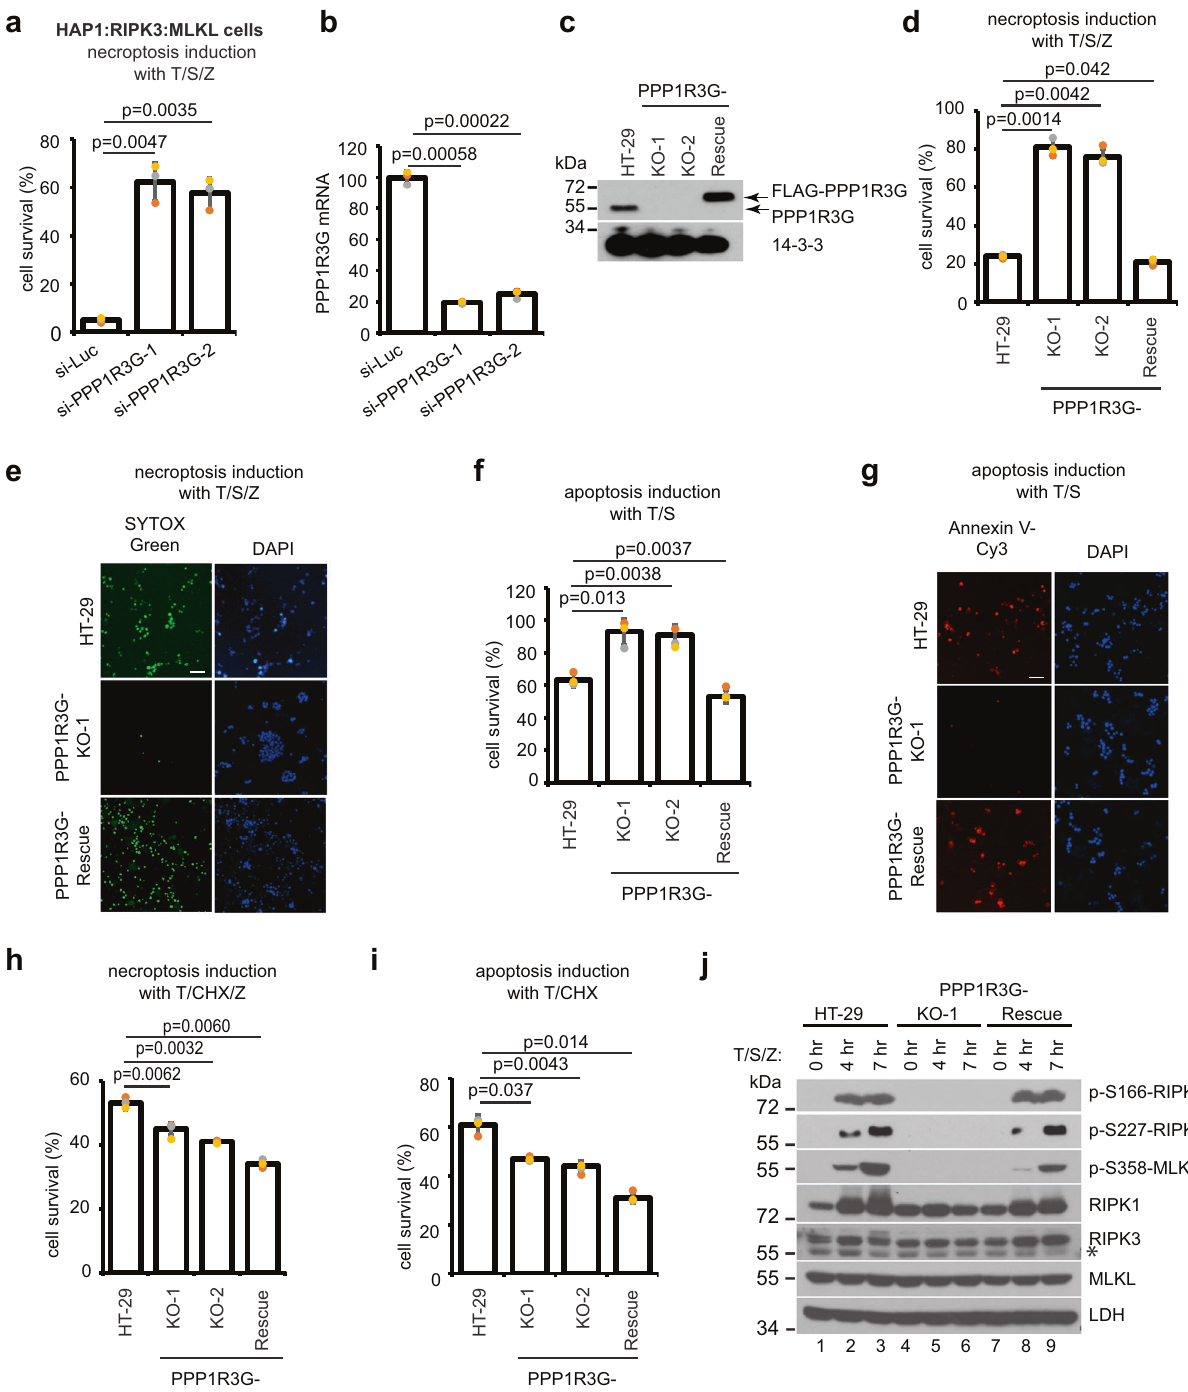
validate the hits, we performed a secondary screen using small addition, knockout of PPP1R3G also blocked T/S-induced interfering RNAs (siRNAs) targeting the top hits in HAP1:- apoptosis, assayed by CellTiter-Glo and Annexin V staining RIPK3:MLKL cells. Among many positive hits, silencing (Fig. 2f, g). However, when a protein synthesis inhibitor CHX was PPP1R3G with two different oligos ef fi ciently inhibited necrop- used to induce necroptosis with TNF and Z-VAD-FMK, tosis (Fig. 2a, b and Supplementary Fig. 2). The same effect was PPP1R3G-KO cells did not show any resistance. In fact, they observed in another cell line, human colon cancer HT-29 cells, displayed slightly more cell death than parental HT-29 cells which express endogenous RIPK3 and MLKL. Inactivation of (Fig. 2h). The same was true with T/CHX-induced apoptosis PPP1R3G by CRISPR-Cas9 in HT-29 cells blocked T/S/Z- (Fig. 2i). It is known that T/CHX-induced cell death depends on induced necroptosis (Fig. 2c – e). Furthermore, stably expressing a complex IIa (TRADD/FADD/caspase 8) formation and does not similar level of 3xFLAG-tagged PPP1R3G by lentiviral trans- require RIPK1, while T/S-induced RDA and T/S/Z-induced type I duction in the KO cells rescued cell death effect (Fig. 2c – e). In necroptosis depend on RIPK1 kinase activation 14,15 . NATURE COMMUNICATIONS| (2021) 12:7067